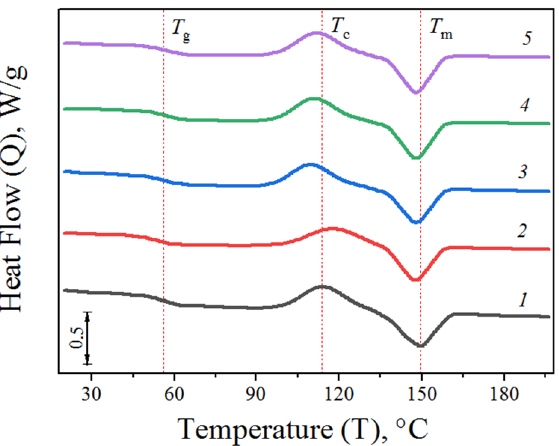
Figure 4. Results of DSC analysis of PLA (1) and PLA/AONF composite films with different AONF